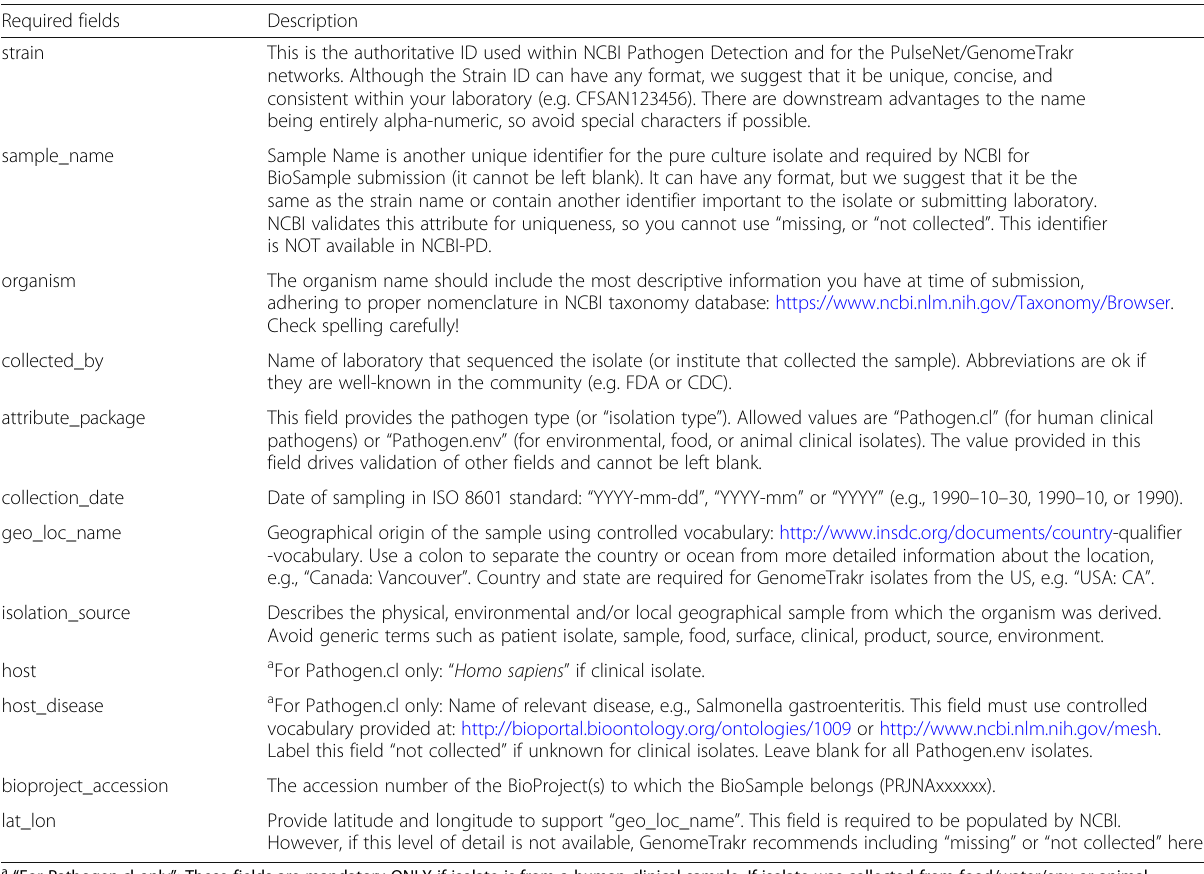
Table 2 The minimum set of metadata fields recommended by GenomeTrakr for BioSample submission of bacterial pathogens. Consult the “ Populating the NCBI Pathogen metadata template protocol ” [32] for expanded, up-to-date